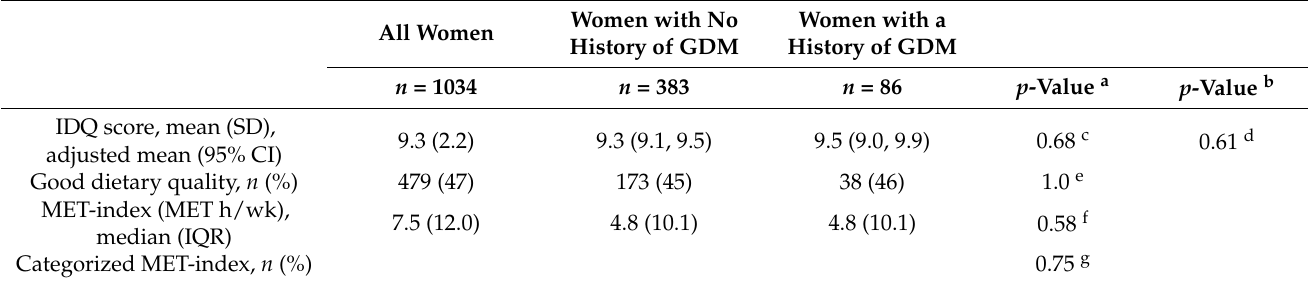
Table 2. Dietary quality and physical activity in the women without and those with a history of gestational